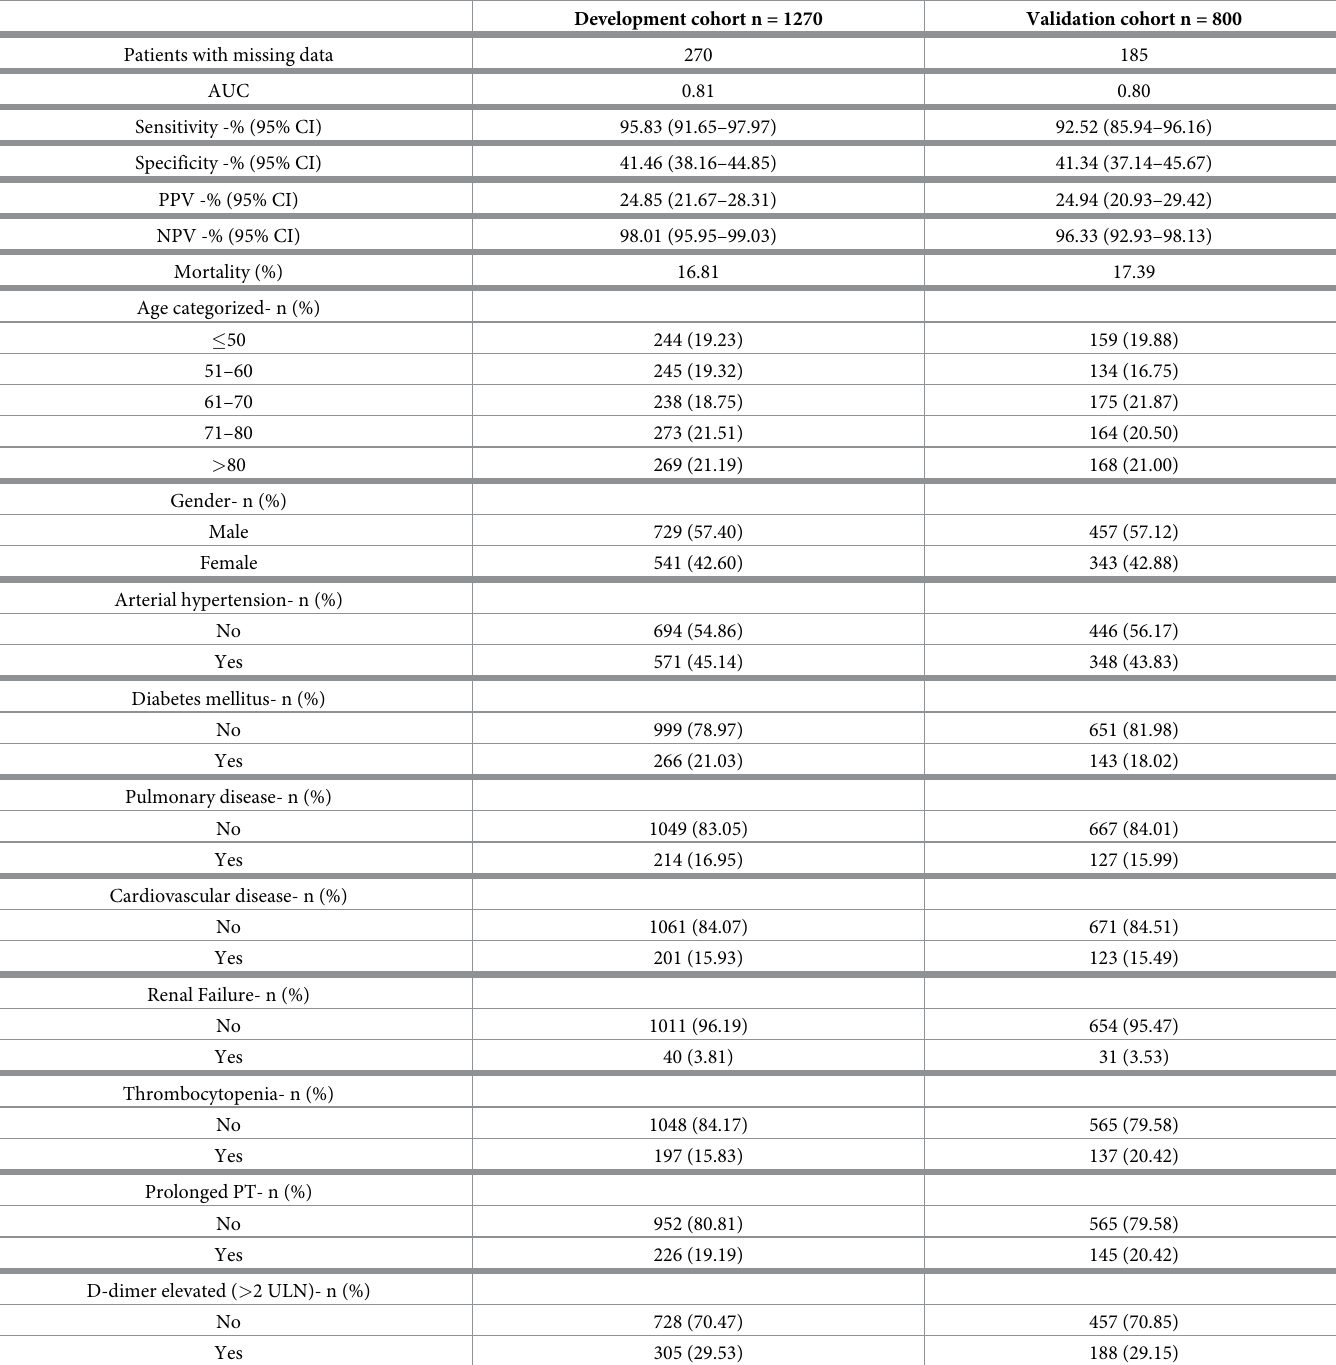
Table 3. Comparison of the distribution of parameters, AUC, sensitivity, specificity, PPV and NPV in the development and validation cohorts of MRS-COVID-19